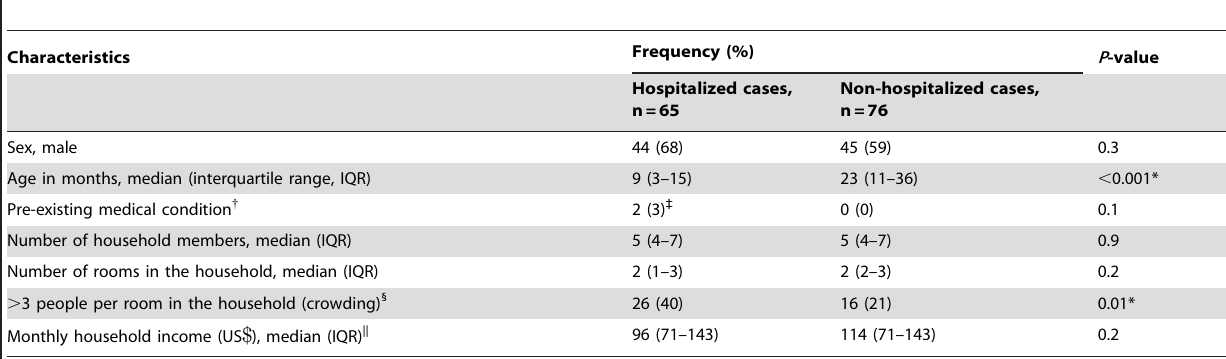
Table 2. Demographic characteristics and underlying health status of children aged , 5 years with severe acute respiratory infections in Matlab, Bangladesh, June–October 2010.